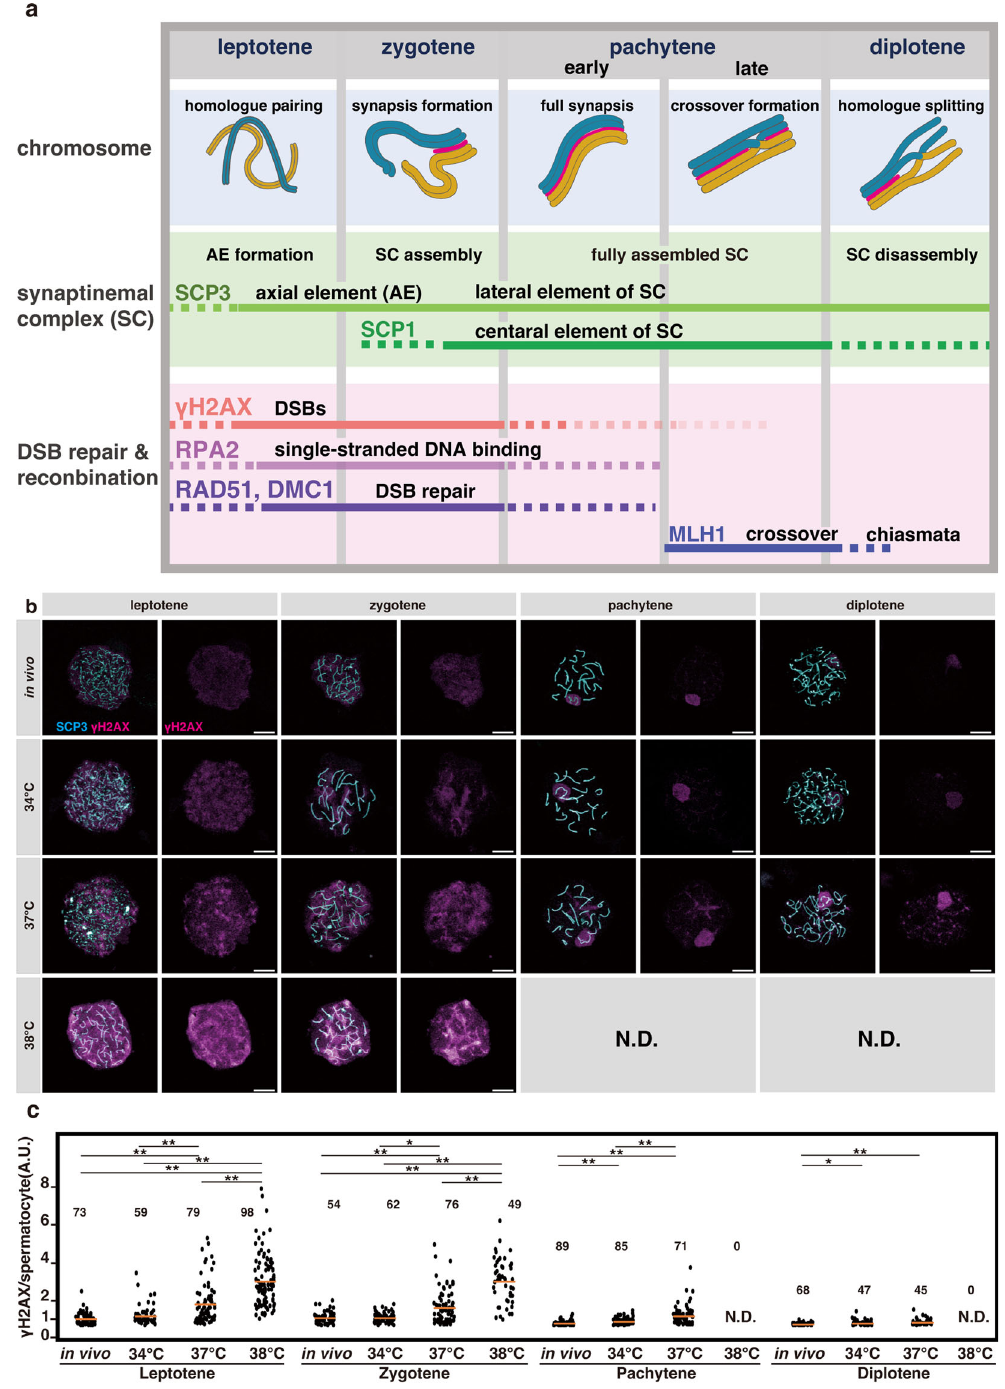
Fig. 4 Events in meiotic prophase I and evaluation of DNA double-strand breaks (DSBs) at different temperatures. a Schematic representation of the stages of progression and events during mouse meiotic prophase I, and the expression of key proteins assayed in this study. Early pachytene includes those before stage IV of seminiferous epithelium, while those at stage IV or later are designated as late pachytene. b Representative images of chromosome spreads of spermatocytes in meiotic prophase I substages prepared from the testes of 5-week-old Acr-GFP mice and testis explants cultured for fi ve weeks at 34, 37, or 38 °C. Samples were stained for γ H2AX (magenta) with SCP3 (cyan) used for staging. The γ H2AX signals are also shown separately in the right panels. Scale bars, 10 μ m. c Dot plots showing the levels of the γ H2AX signal in each spermatocyte nucleus at the indicated substage quanti fi ed from immuno fl uorescence images as shown in ( b ). Each dot represents an individual spermatocyte with horizontal bars indicating the mean values. The number of spermatocytes analyzed are indicated above the plots (N.D. not detected). Cells prepared from four testes from different individuals, and 14, 15, and 15 explants cultured at 34, 37, and 38 °C, respectively, were pooled for each sample. Multiple comparisons were conducted using the Kruskal – Wallis test among all values within each category and gave p -values of 2.31E-34, 1.13E-19, 2.53E-19, and 3.76E-5 for leptotene, zygotene, pachytene, and diplotene, respectively, and using the Steel – Dwass test for combinations of two values within each category resulting in the p -values as indicated in the plots (* p < 0.05, ** p < 0.01). COMMUNICATIONS BIOLOGY| (2022) 5:504 |https://doi.org/10.1038/s42003-022-03449-y|www.nature.com/commsbio